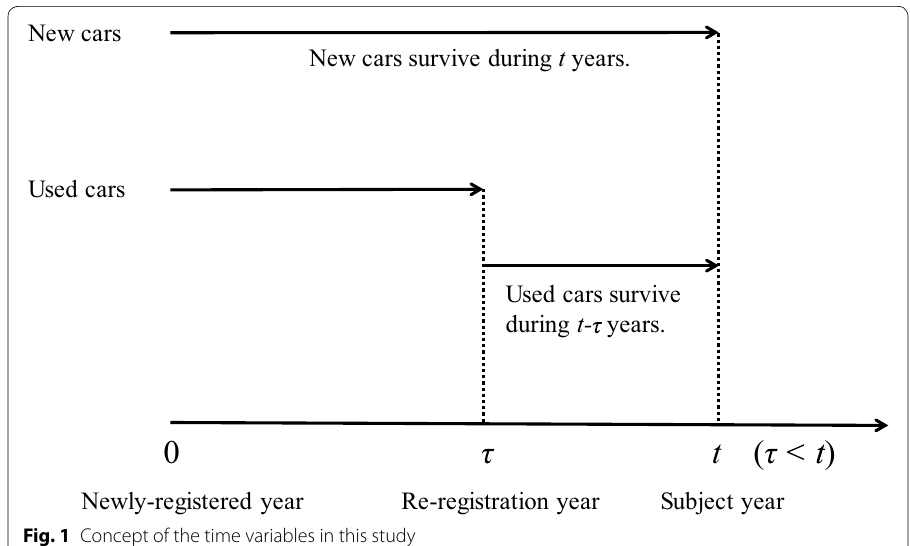
Fig. 1 Concept of the time variables in this